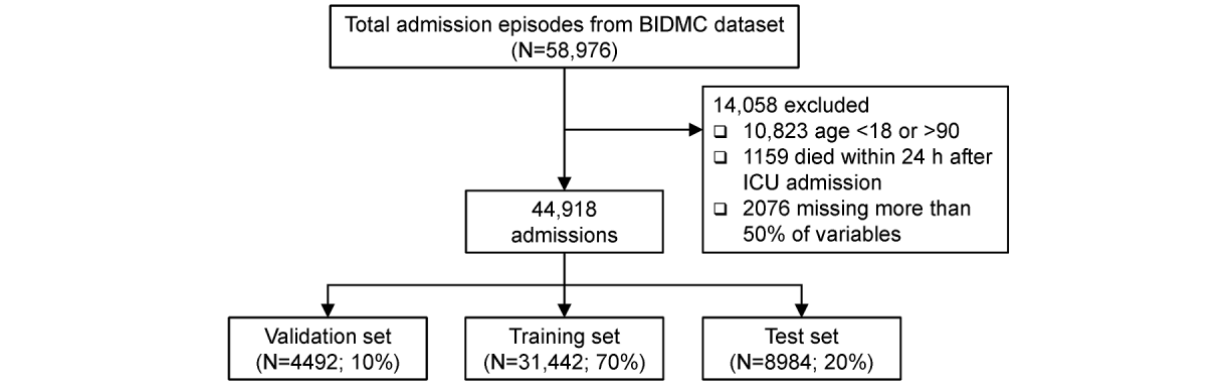
Figure 2. Flowchart of the study cohort formation. BIDMC: Beth Israel Deaconess Medical